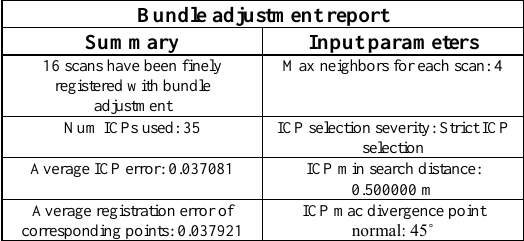
Table 1. Summary report after